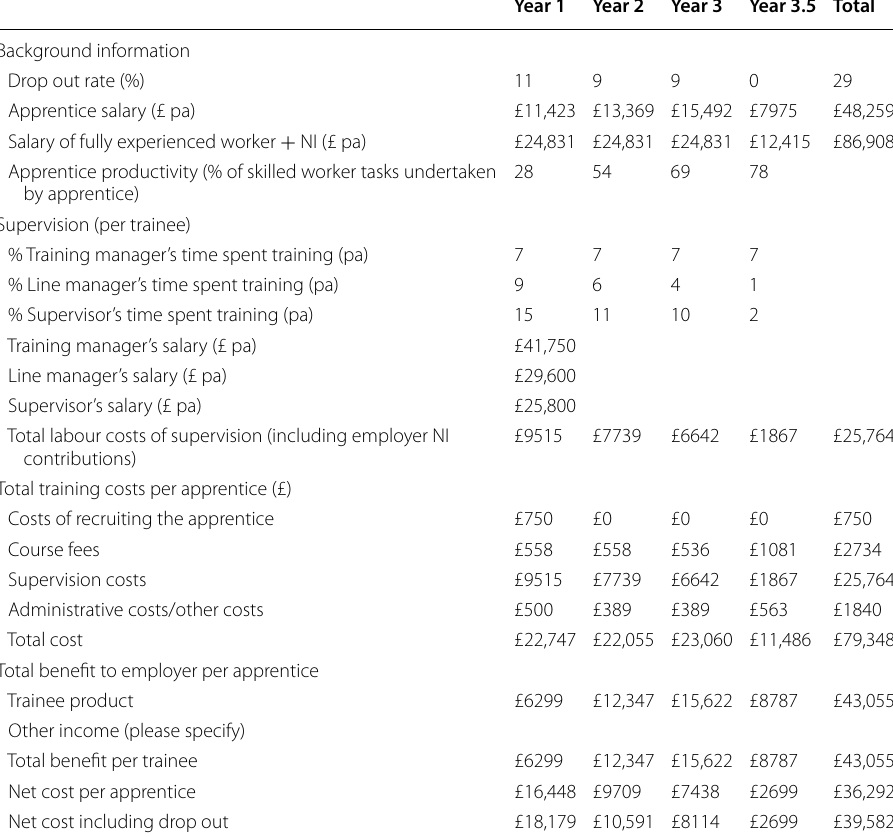
Table 3 Net costs of training an apprentice in engineering at Level 3, 2011. Source: